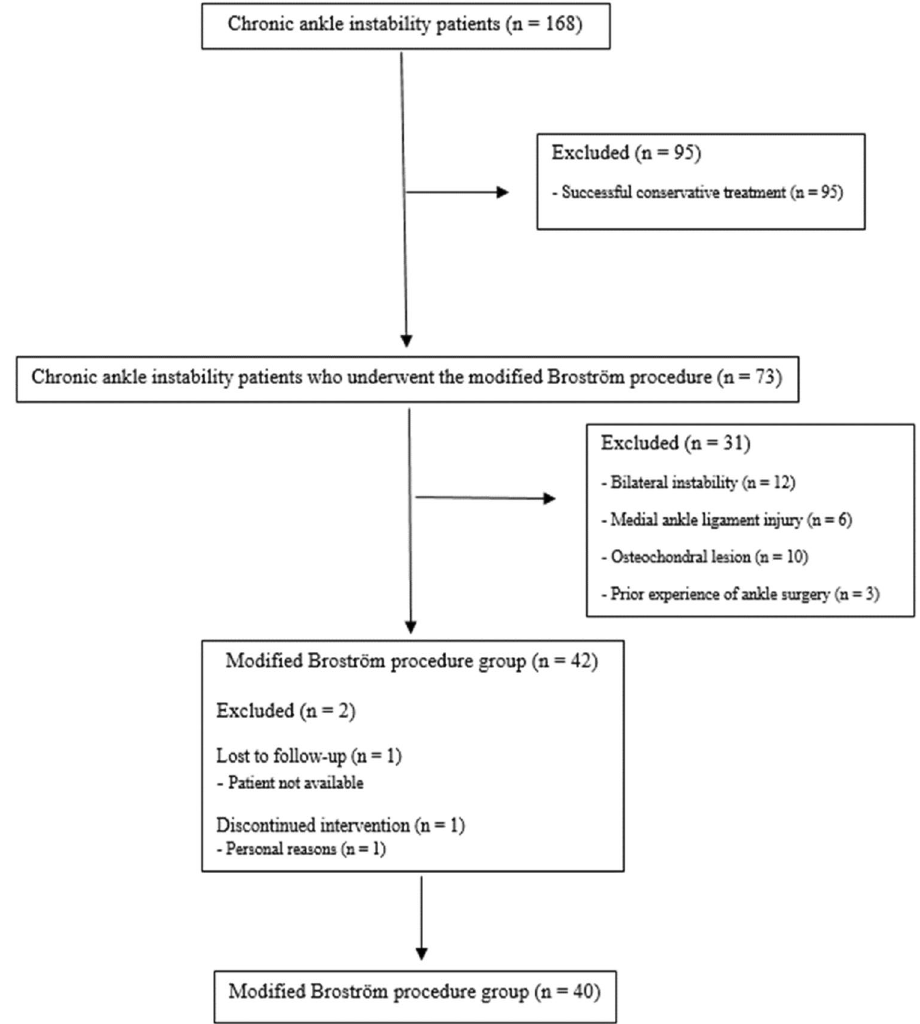
Figure 1. Flowchart of chronic ankle instability patients who underwent the modified Broström